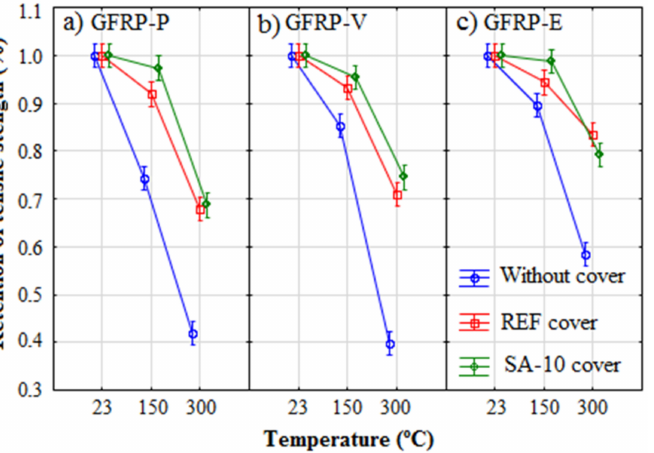
Figure 10. Relation between the retention tensile strength and the test temperature for samples